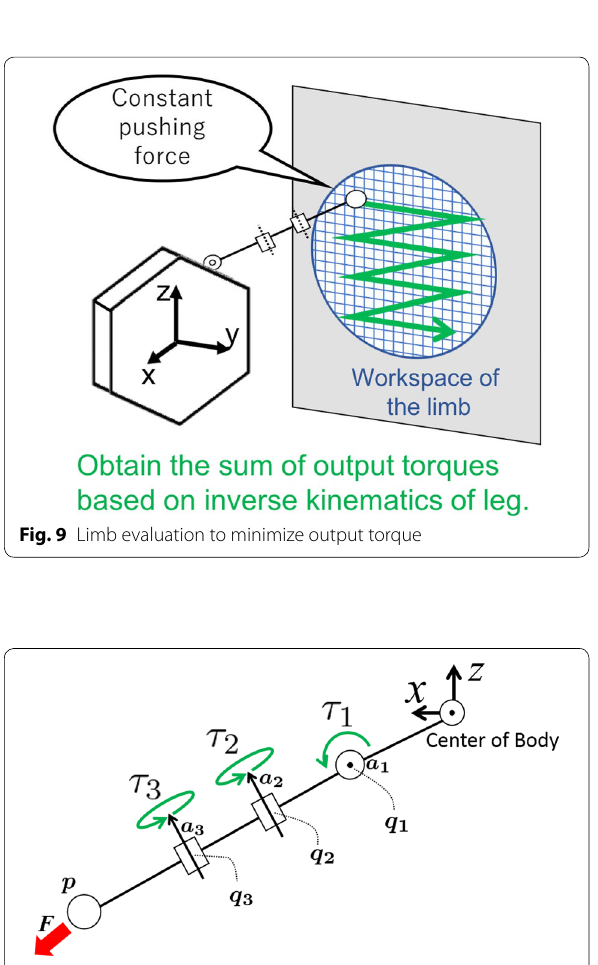
Fig. 10 Inverse statics relating tip force and joint torques